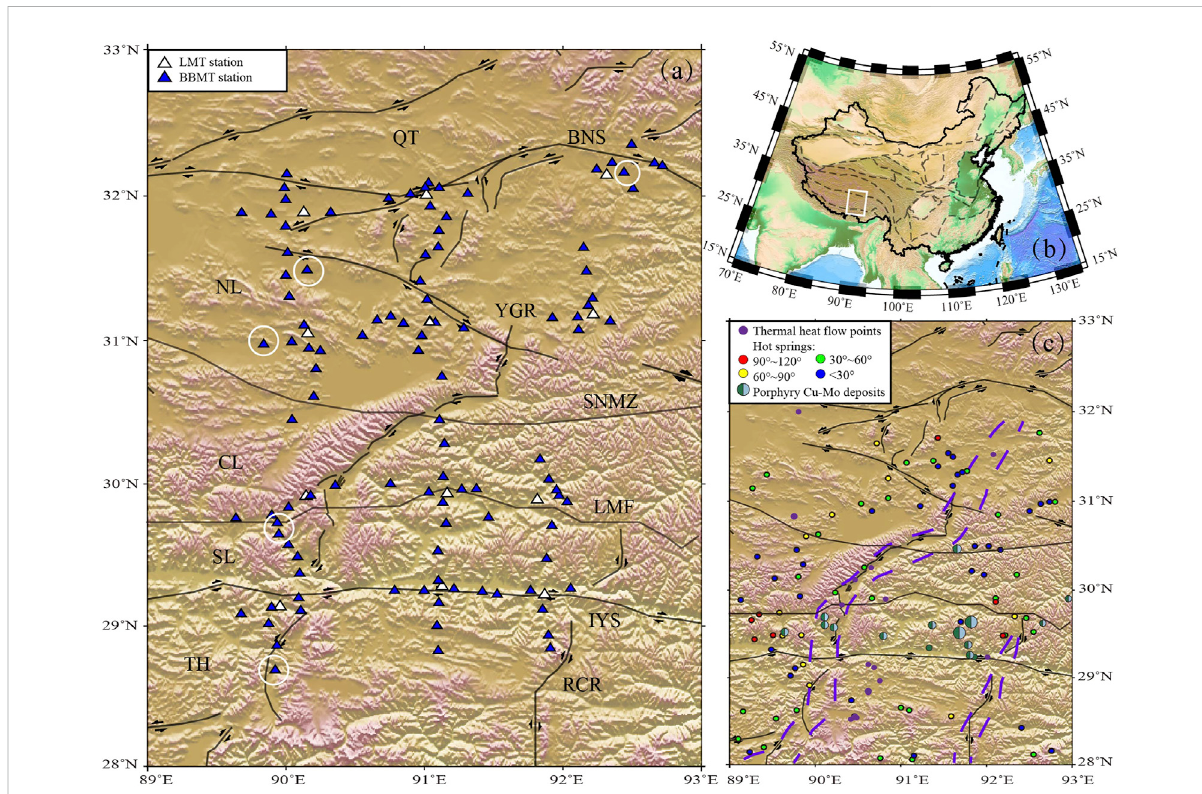
FIGURE 1 (A) Topographic map of study area showing location of broad-band MT stations (blue triangles) and long-period MT stations (white triangles). The green lines mark the locations of the electrical resistivity pro fi les. QT, Qiangtang terrane; NL, northern Lhasa; CL, central Lhasa; SL, southern Lhasa; TH, Tethys-Himalaya terrane; BNS, Banggong-Nujiang suture; YGR, Yadong-Gulu rift; RCR, Riduo-Cuona Rift; SNMZ, Shiquanhe-Yongzhu- Nam TsoMélangeZone; LMF, Luobadui-Milashanfault; IYS, Indus-YarlungZangbosuture (B) The extentofour study area(whiterectangle). (C) Location of the thermal heat fl ow points (purple circles), hot springs (red, yellow, blue, and green circles), porphyry Cu-Mo